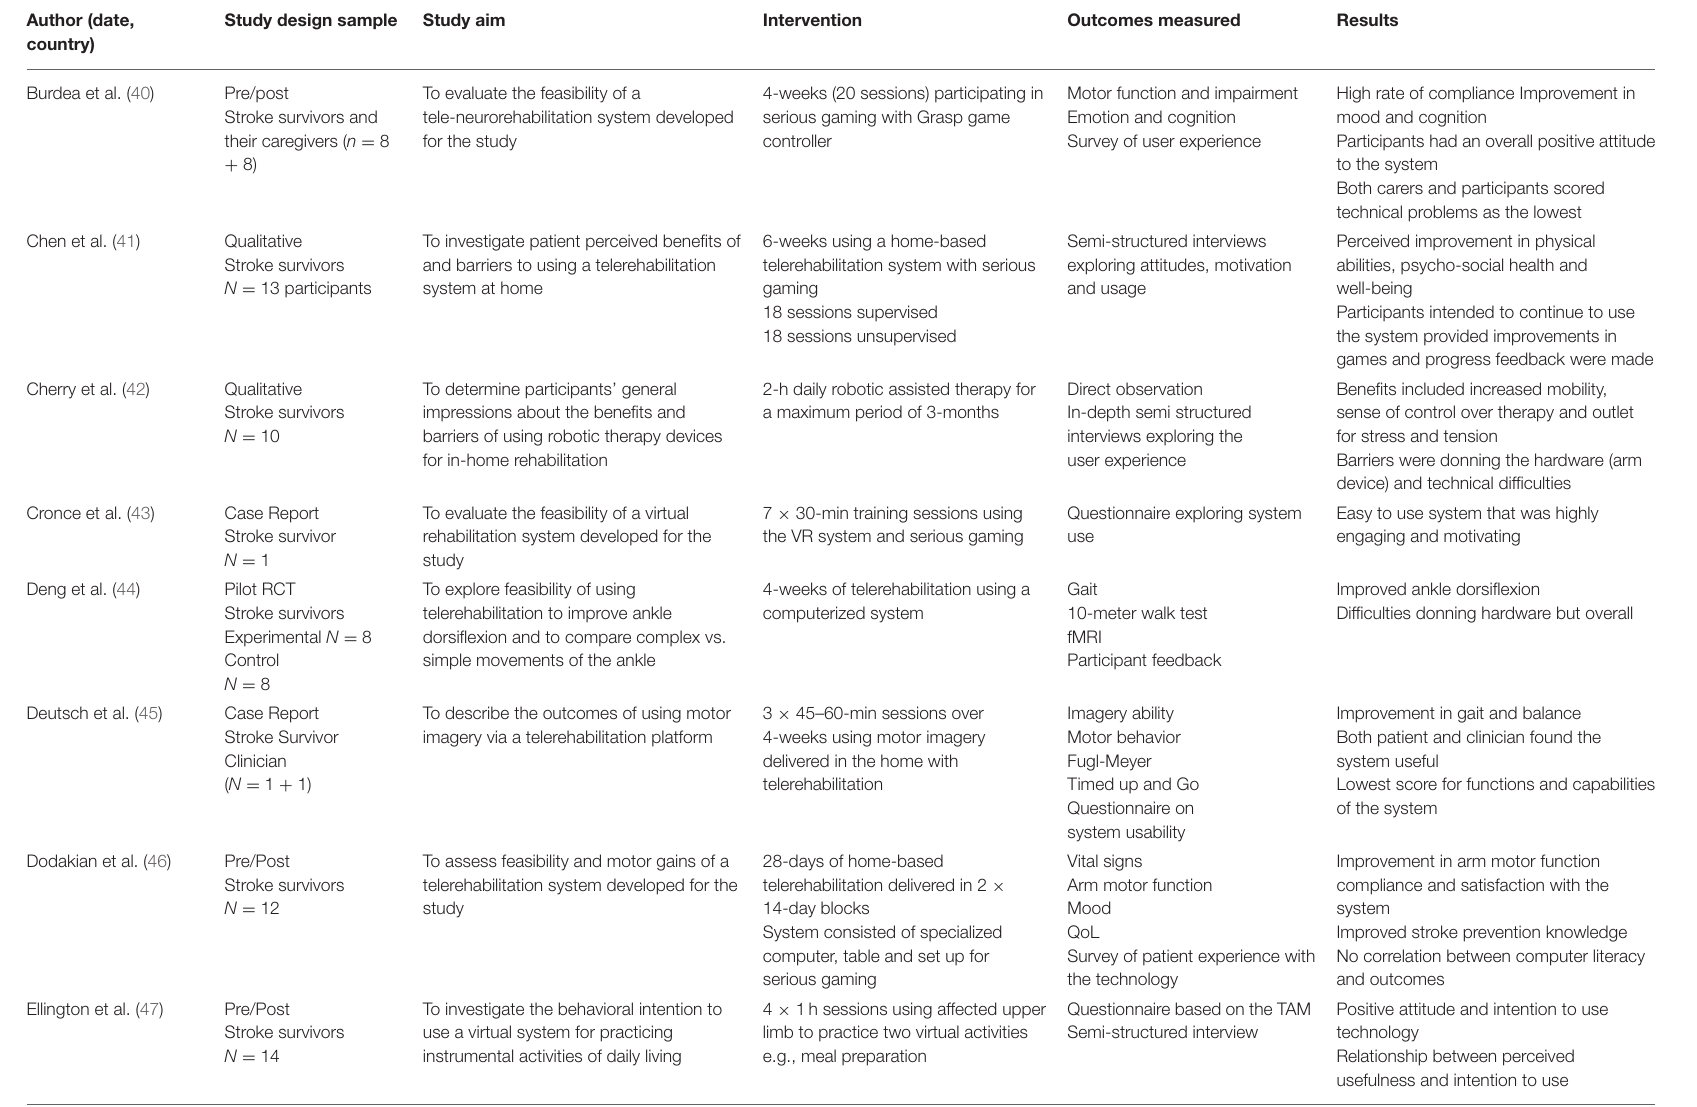
TABLE 1 | Data extraction for studies included in the mapping